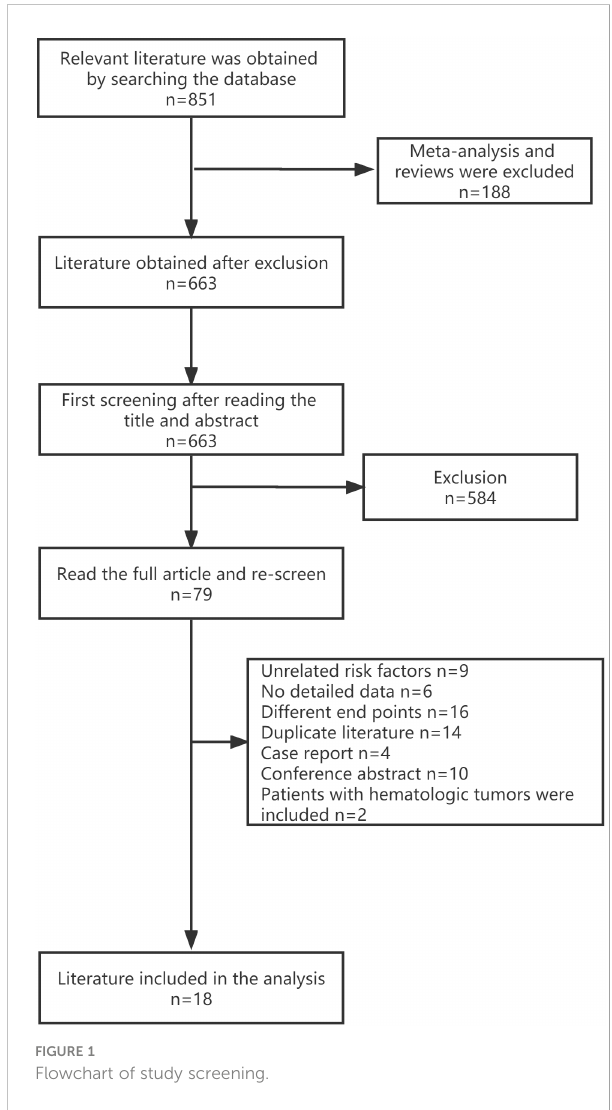
FIGURE 1 Flowchart of study